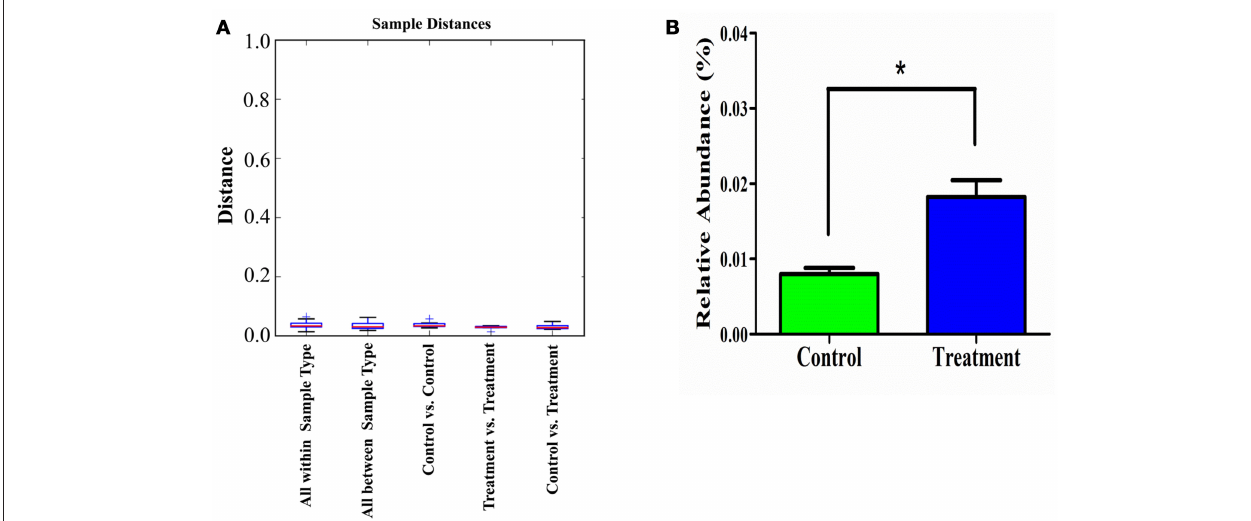
FIGURE 8 | Weighted unifrac distance ( β -diversity) of the cecal microbiota (A) and relative abundance of Enterococcus (B) in male rats after oral administration of Enterococcus durans KLDS6.0930 for 28 days. Control, sterile normal saline; Treatment, 1 × 10 9 CFU of E. durans KLDS6.0930 /kg BW. Statistical analysis was conducted by unpaired two-tailed student’s t-test. * P <